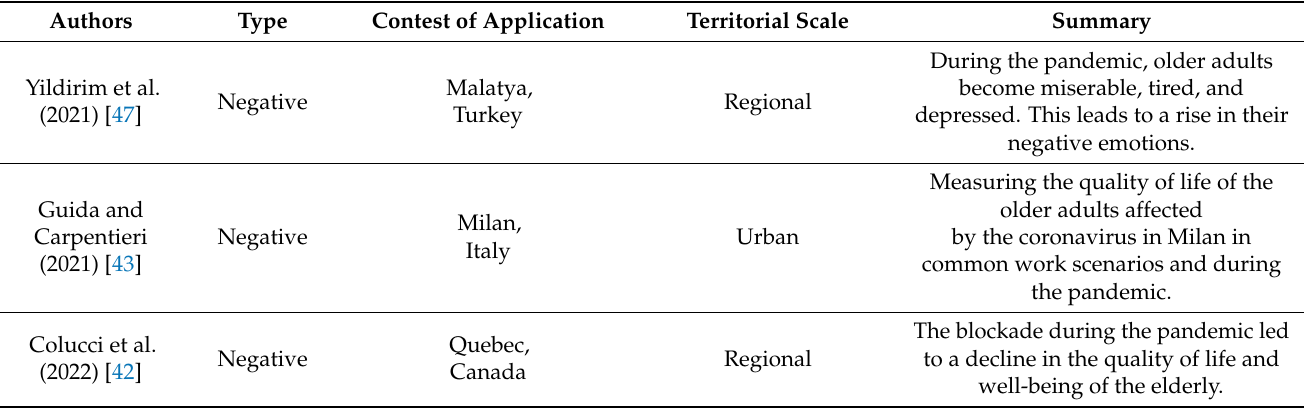
Table 1. Classification of studies on the quality of life in older age groups during the